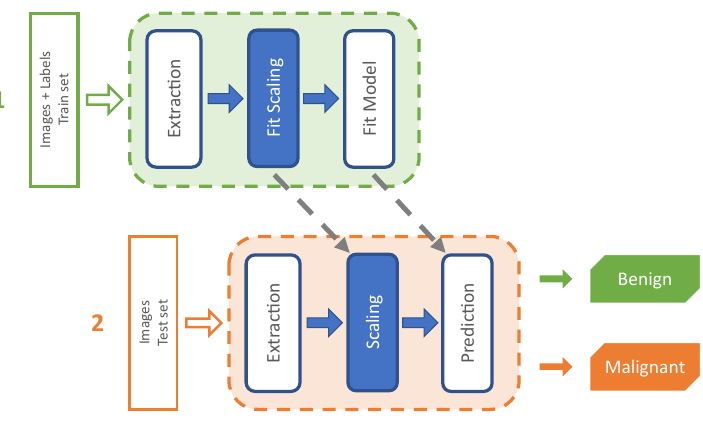
Figure 3. The classification process performed on the RCM images. The “Extraction” box refers to one of the Feature Extraction methods mentioned in Section 2.2. The “Fit Model” and “Prediction” boxes are related to the training and inference steps, respectively, of one of the trained and inferred models discussed in Section 2.3. The testing set was predicted based on two classes: “benign” and